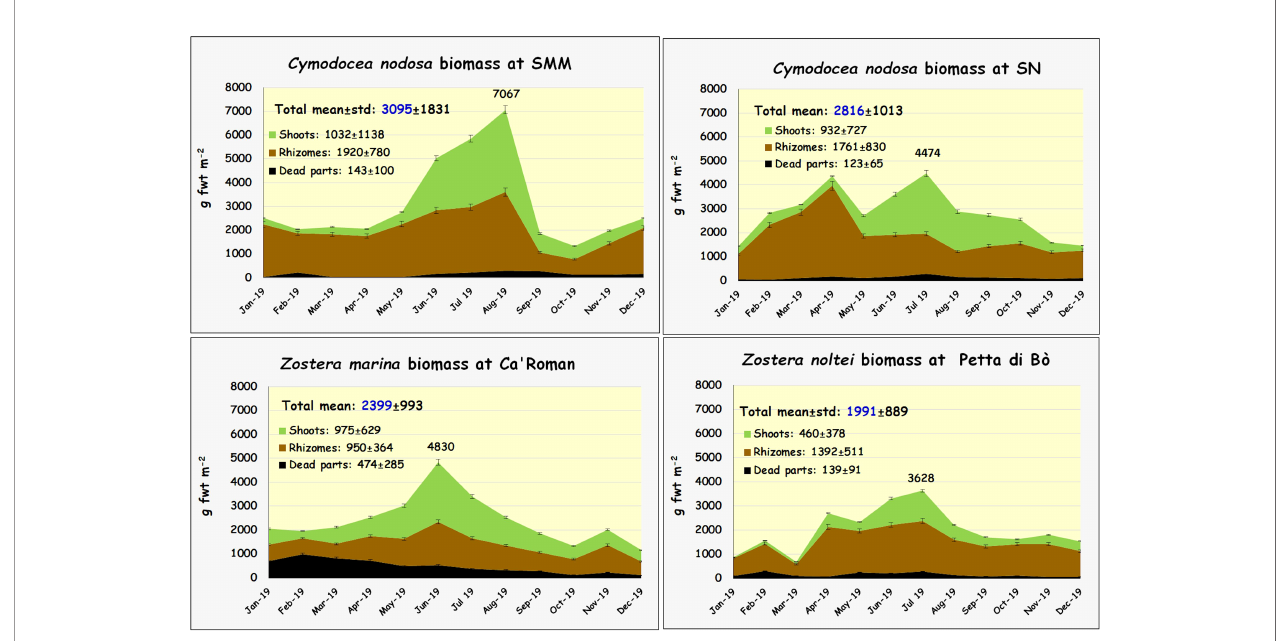
FIGURE 3 | Biomass changes of C. nodosa, Z. marina , and Z. noltei during the